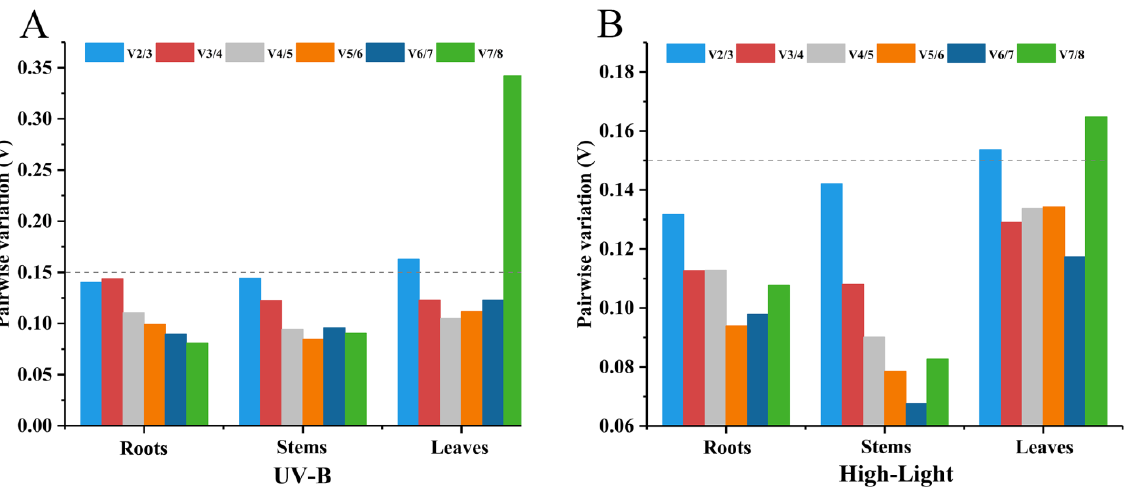
Figure 3. geNorm analysis of the pairwise variation (V) values for eight candidate reference genes under UV-B ( A ) and high-light ( B ) stresses.